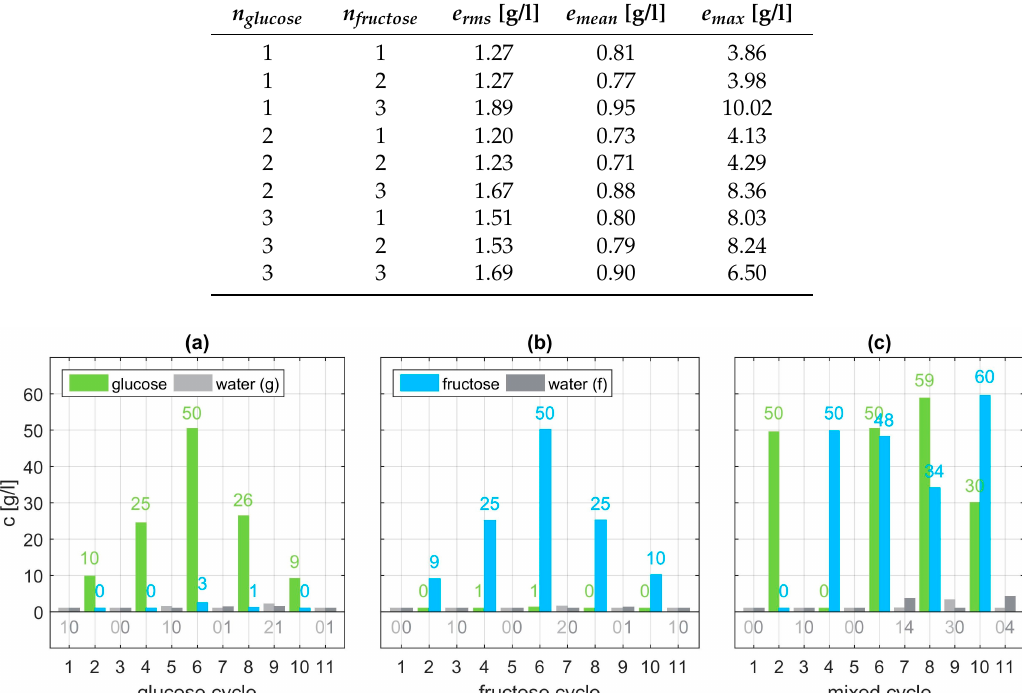
Table 1. Comparison of RMS errors, mean errors, and maximum errors for the estimated concentrations resulting from different combinations of polynomial basis functions ϕ i and ψ i with order n glucose or n fructose respectively.